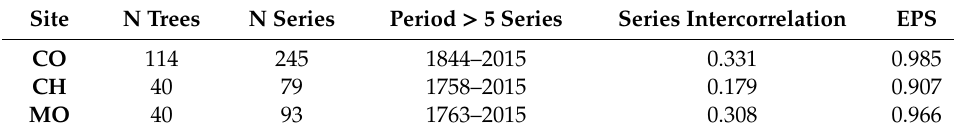
Table 2. Number of dated trees, number of dated series (radii), period with more than five series, average series intercorrelation (Rbar) between series, and expressed population signal (EPS).